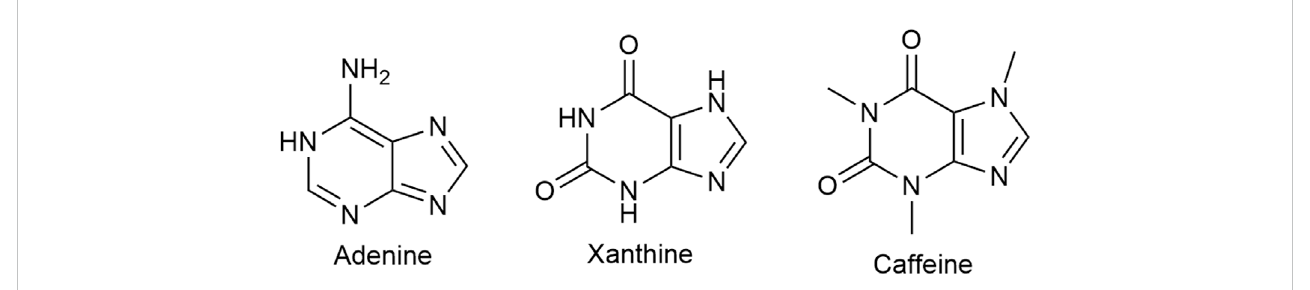
FIGURE 10 Caffeine,axanthinederivative,isanon-selectiveadenosinereceptorblocker.Adenineisaprecursorofxanthineandadeninenucleotideisaprecursorof adenosine.